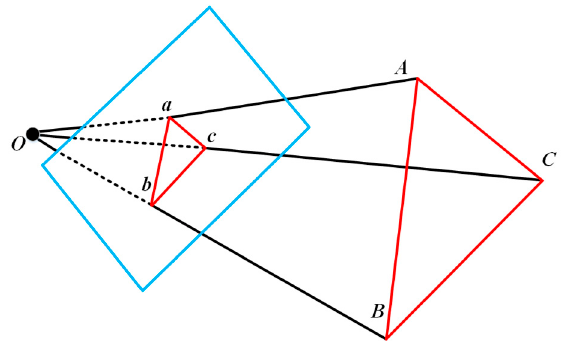
Figure 7. The schematic map of P 3 P.